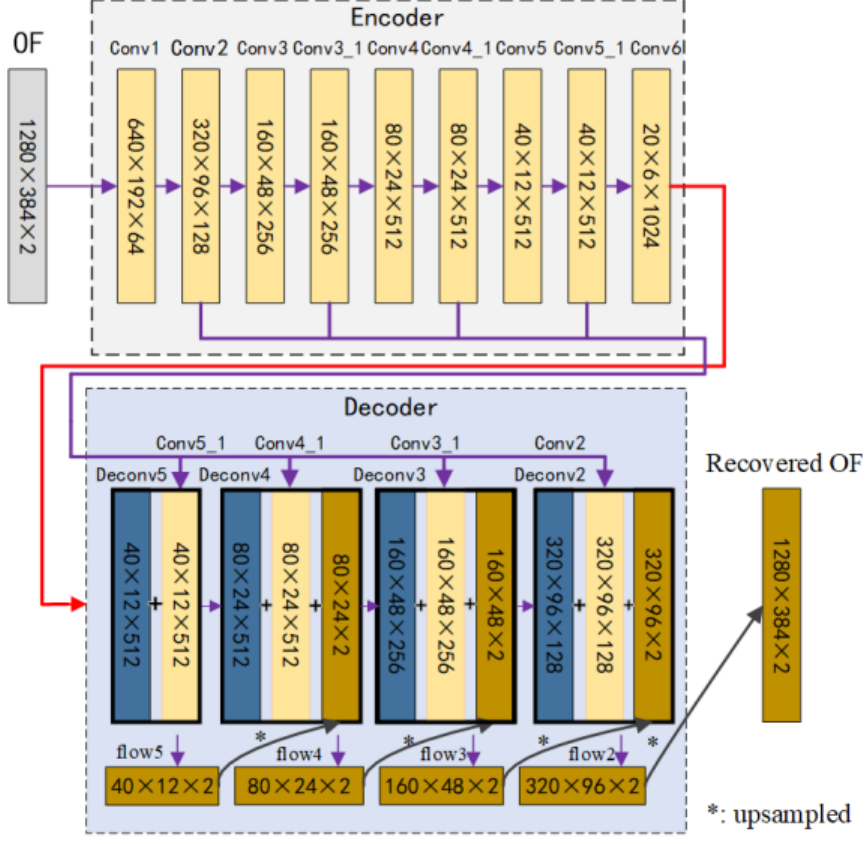
Figure 2. The process of encoding and